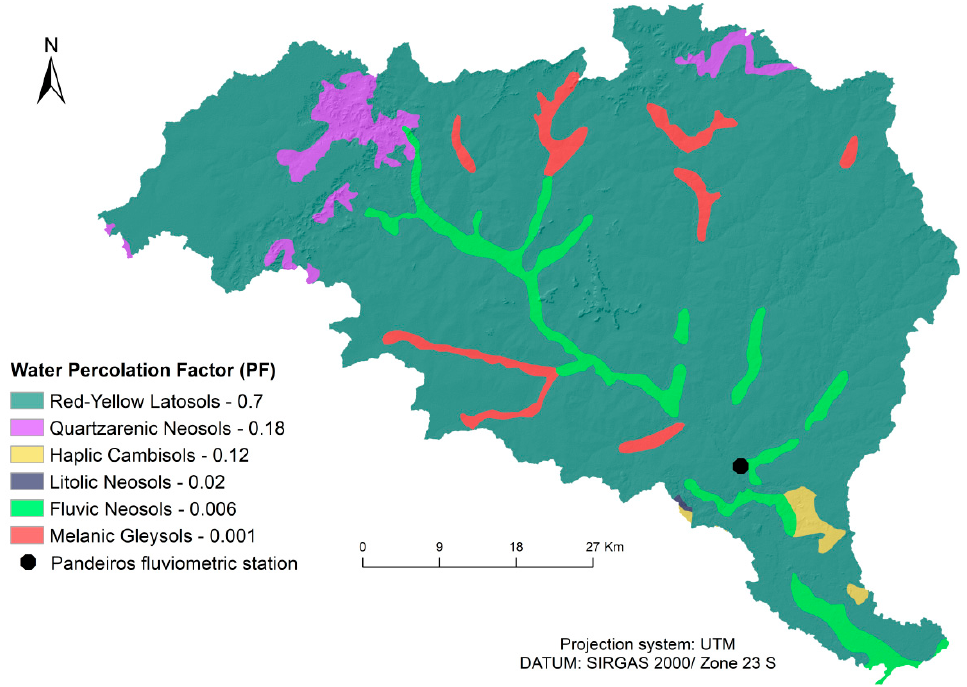
Figure 10. Spatial distribution of water percolation in the Pandeiros River basin.